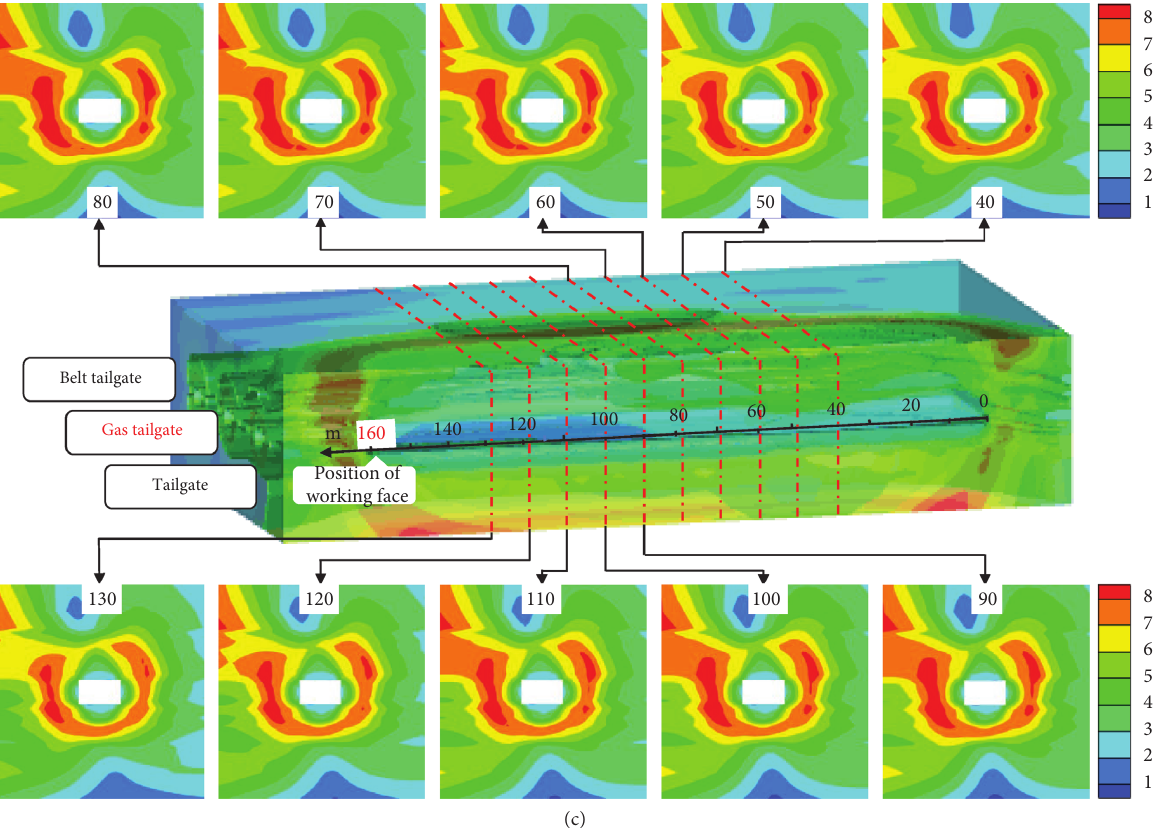
Figure 9: Deviatoric stress distribution of surrounding rock of gas tailgate when the working face is at a certain position. (a) 40m advancement of the working face. (b) 80m advancement of the working face. (c) 160m advancement of the working face (unit: